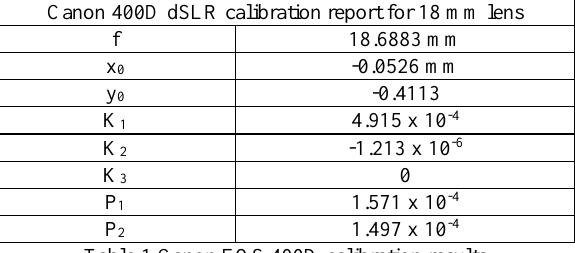
Table 1 Canon EOS 400D calibration